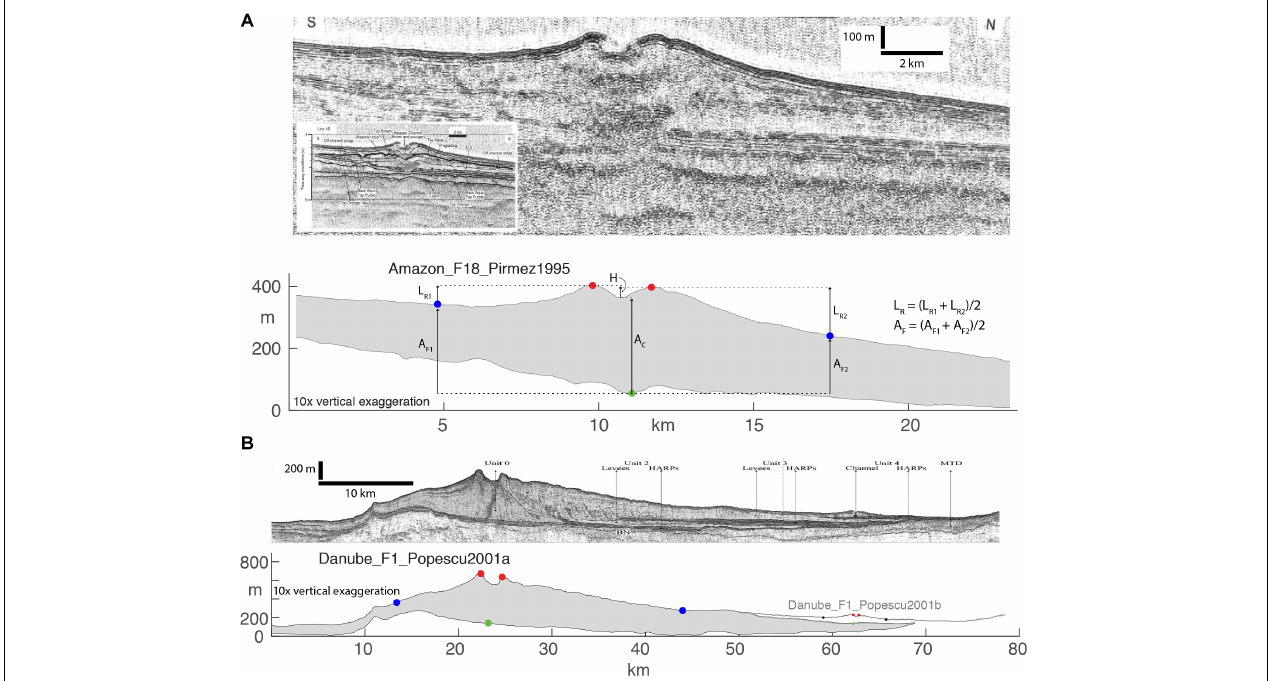
FIGURE 2 | Seismic-reflection profiles and associated measurements of the Amazon channel (A) and Danube channel (B) . Both profiles displayed at 10x vertical exaggeration but are not scaled to each other. Note the significant aggradation of the channel above the floodplain in both channels. Note also the difference in superelevation between the Danube abandoned channel (left) and the modern channel (right). Image in (A) from Pirmez and Flood (1995); image in (B) from Popescu et al. (2001).